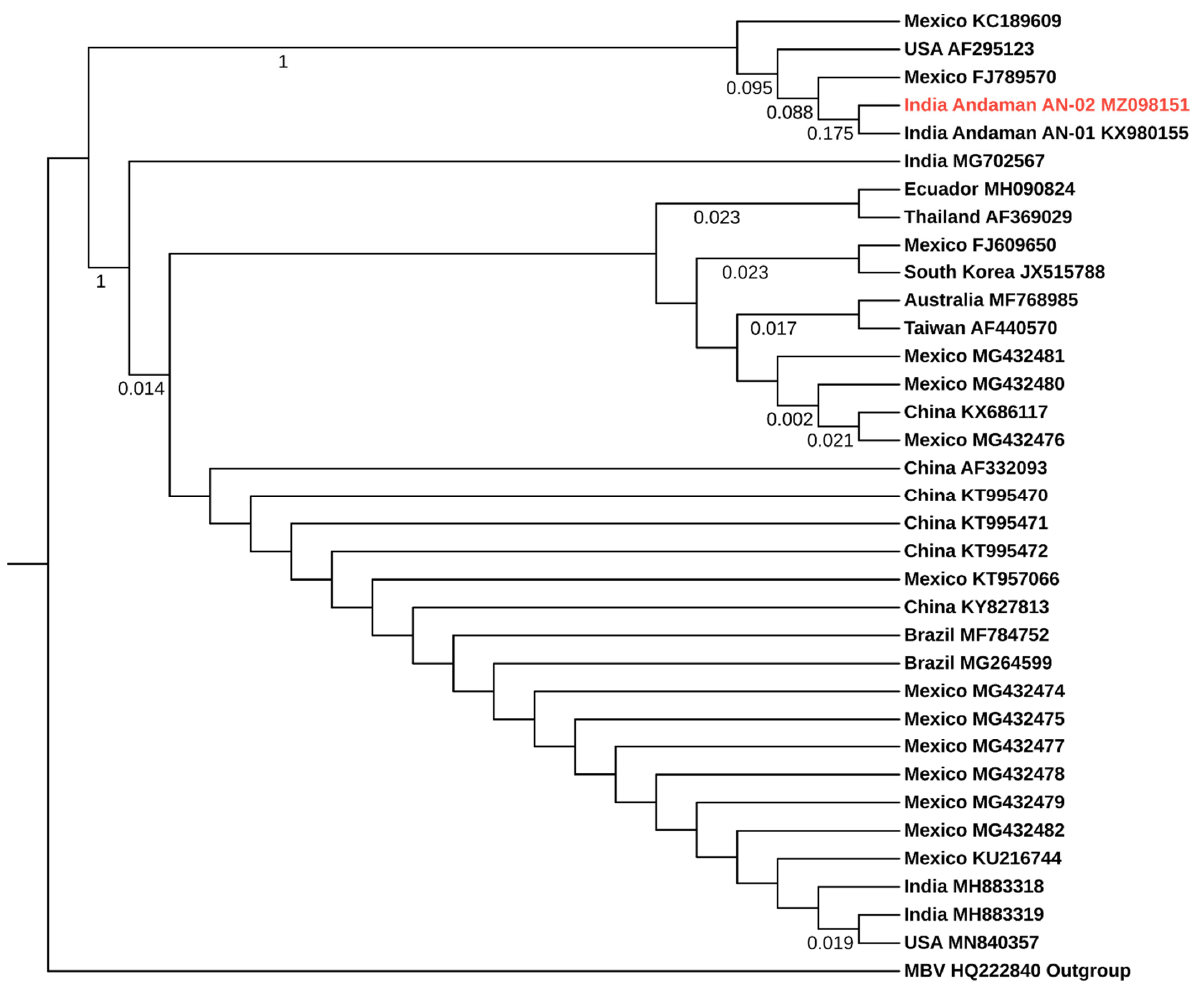
Figure 3. Phylogenetic tree of WSV285 gene of WSSV. The Genbank accession numbers are provided along with the country name and the WSSV sequence obtained in this present study (Genbank accession number MZ098151) was highlighted in red colour text. The tree was constructed using the maximum likelihood method with Tamura 3-parameter model (T92). The polyhedrin-like gene of monodon baculovirus (MBV) was used as an outgroup (Genbank accession number HQ222840).